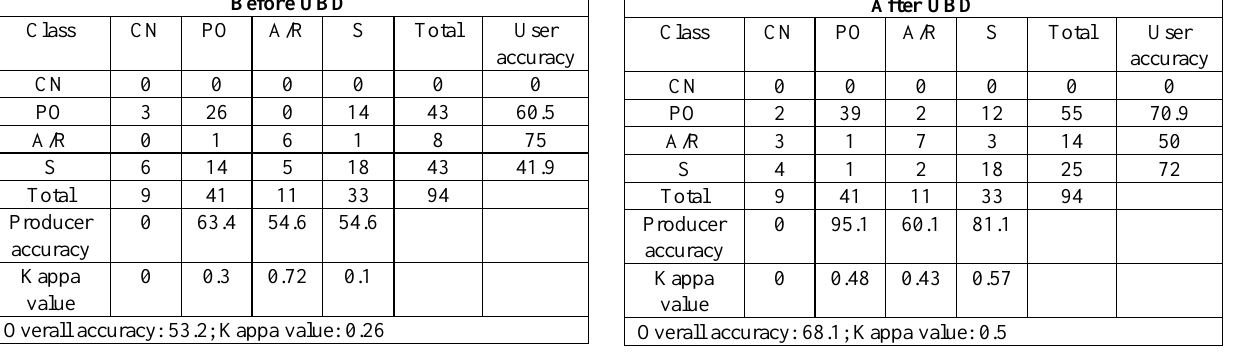
Table 4. Error matrix of Fig. 3D after the application of UBD on Planet imagery. CN: Cymodocea nodosa seagrass , PO: Posidonia oceanica seagrass, A/R: Algae and Rocks, S: Sand seagrasses requires sensors with higher SNR than the ones